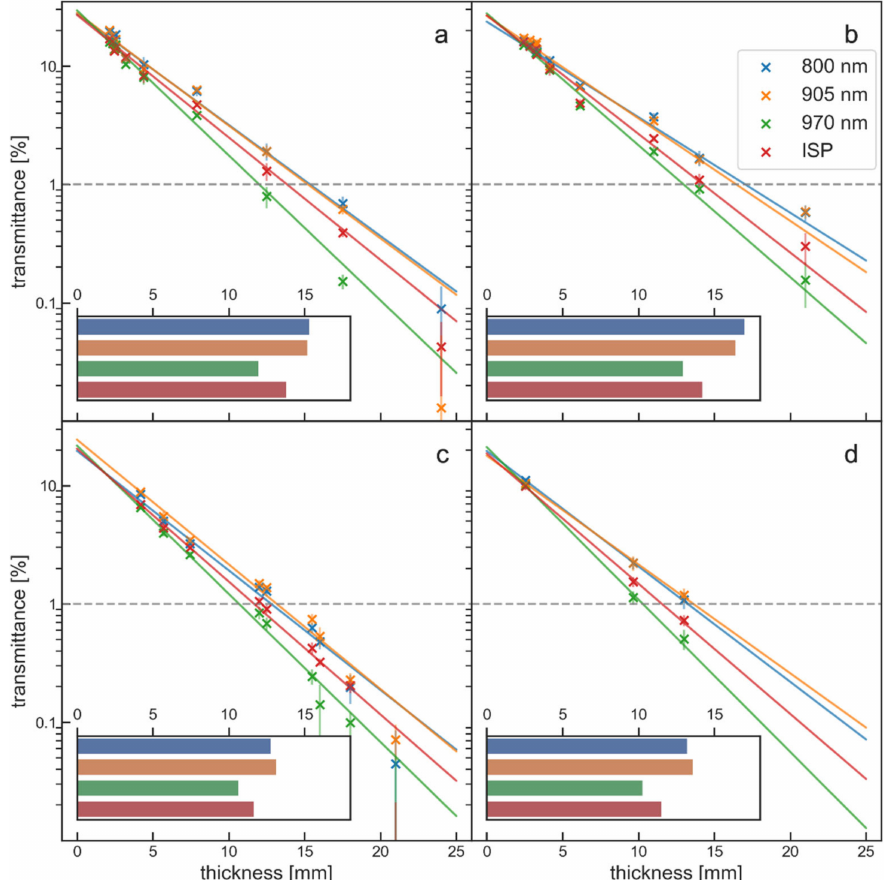
Figure 7. Transmittance of the three different wavelengths of the K-laser (800 nm (blue dots and blue lines), 905 nm (orange dots and orange lines), 970 nm (green dots and green lines)) and its ISP mode (red dots and red lines) for four different tissues (( a ), beef muscle 1; ( b ), beef muscle 2; ( c ), porcine skin; ( d ), beef tendon). Each measurement is plotted with the according standard deviation. The uncorrected transmittance is plotted in logarithmic scale to enhance the difference between the different wavelengths and modes. The insets show for each tissue type the 1% penetration depths of the different K-laser wavelengths and modes as bar-plots. The insets have the same x-axis as the main penetration depth